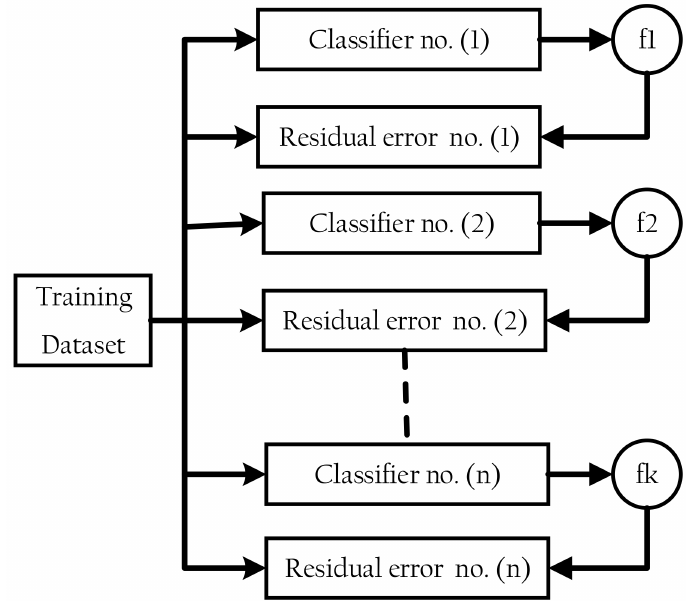
Figure 2. Extreme gradient boosting